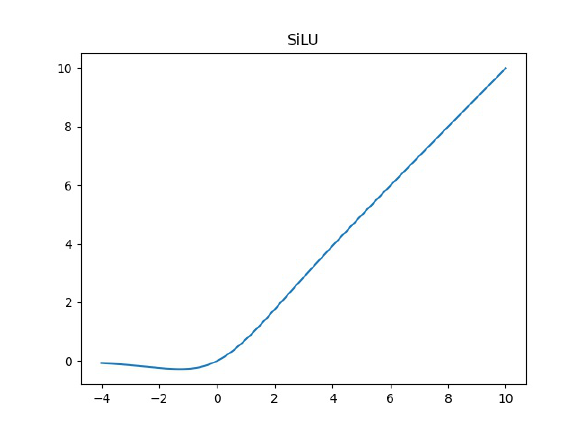
Fig. 2. Diagram of the SiLU activation